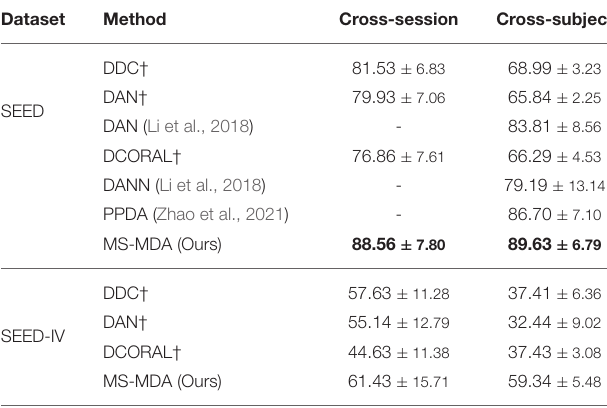
TABLE 2 | Comparison results on SEED and SEED-IV of accuracy.